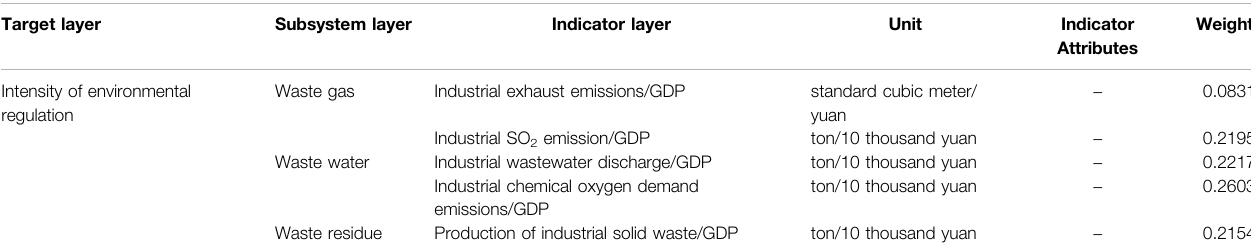
TABLE 2 | Index system of environmental regulation intensity in